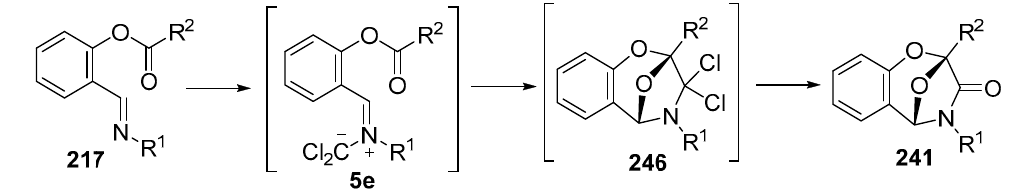
Figure 4. Analogous azomethine ylide that fails to undergo intramolecular cycloaddition.